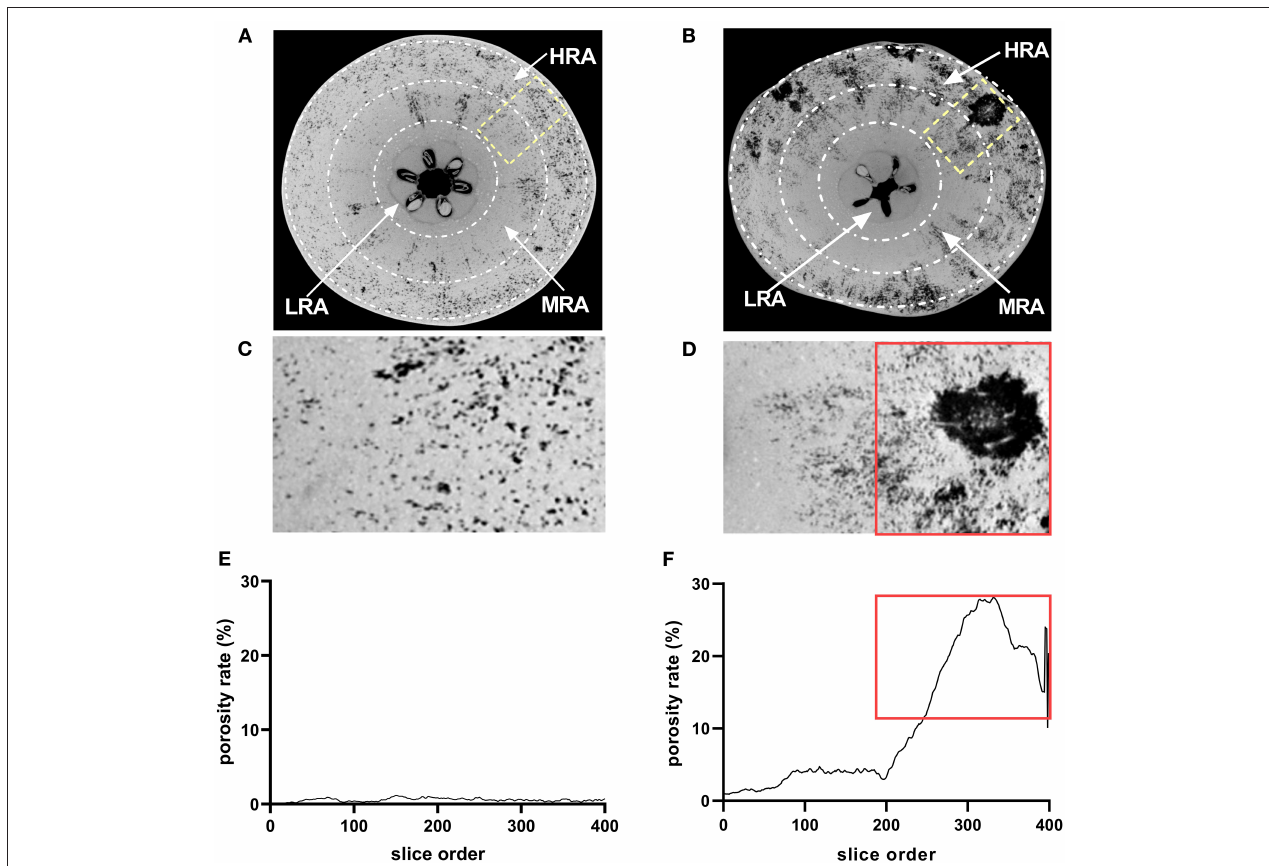
FIGURE 4 | Microstructure analysis of specific areas of “Akizuki” fruit. (A,B) Equatorial plane of healthy and cork spotted fruit, respectively. The HRA, MRA, and LRA were defined as the high-risk area with cork spot, the middle-risk area with cork spot, and the low-risk area with cork spot, respectively. (C,D) Closer view of (A) marked in yellow rectangle and of (B) marked in yellow rectangle, respectively. (E,F) Porosity analysis of (C,D) , respectively. Red rectangles in (D,F) represent the tissues and their corresponding